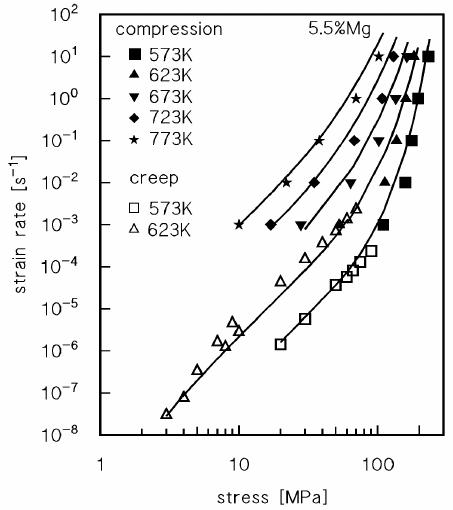
Figure 11. Compression data for 5.5%Mg [28] and creep data from [1,30]. The curves were calculated, as in Figure